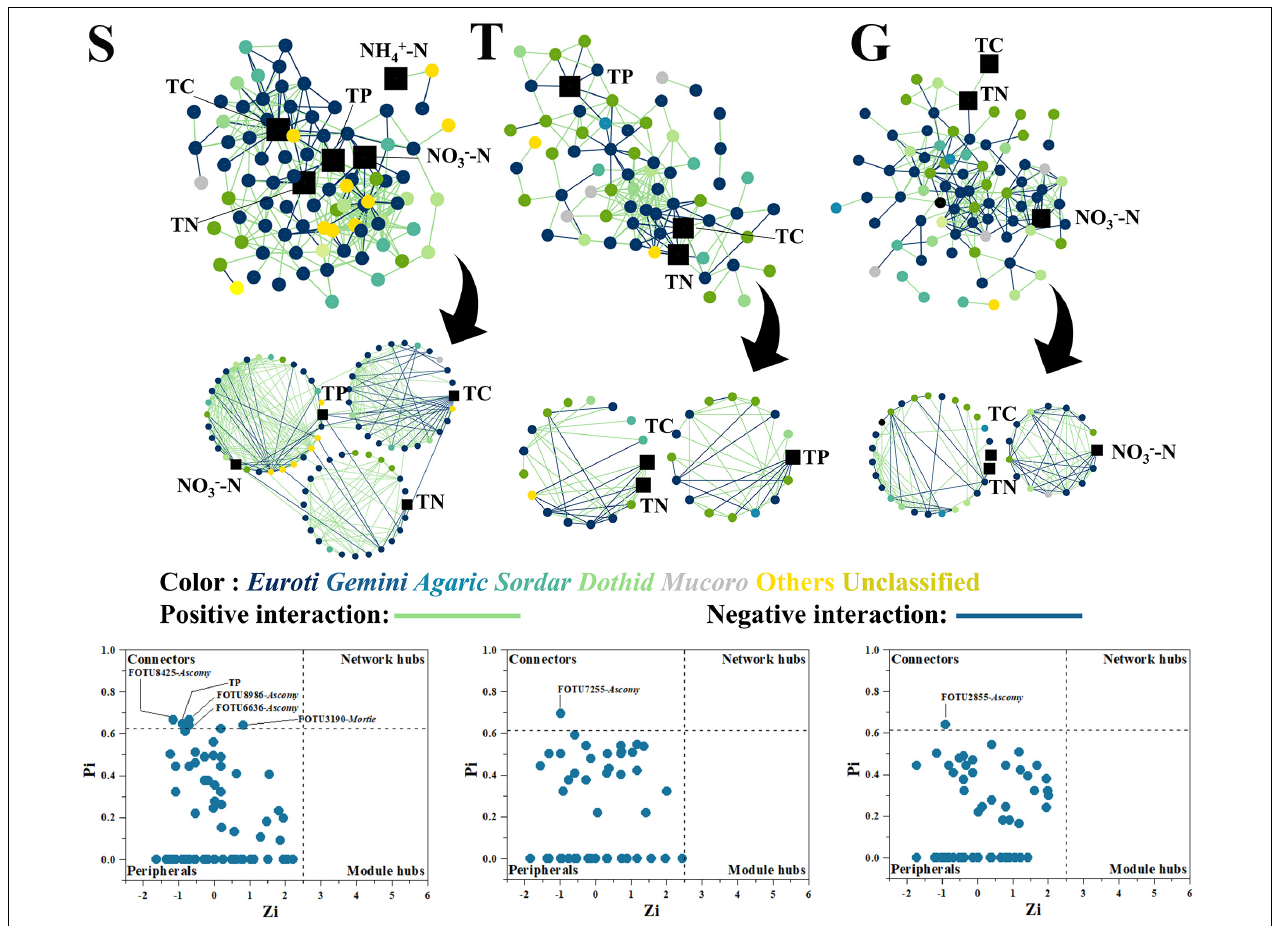
FIGURE 4 | The fungal network, with functional modules and key node composition. The phylogenetic identity of nodes (class level) is depicted by different colors; network positive and negative interactions are depicted as green and blue lines, respectively. The environmental factors are depicted as black squares. The “ Euroti ” is the abbreviation for “Eurotiomycetes” and similarly to other fungal